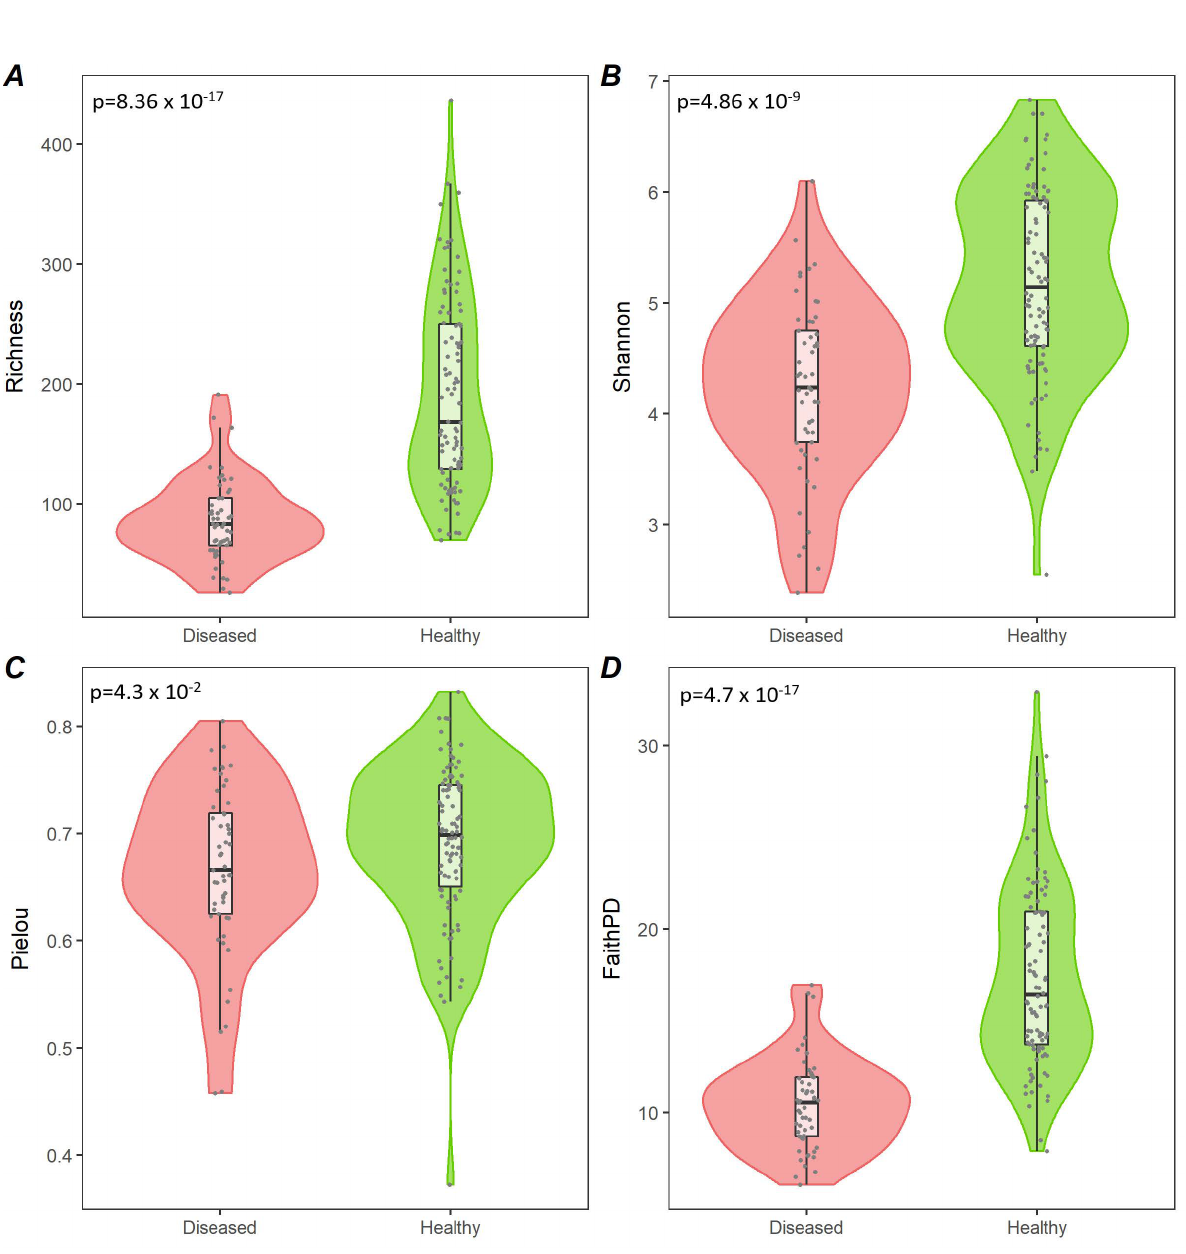
Figure 1. Alpha diversity comparison between healthy and diseased dogs. Violin plots representing alpha values in healthy (green) and diseased (red) groups according to richness ( A ), Shannon ( B ), Pielou ( C ), and Faith’s ( D ) phylogenetic diversity measures. The related p -values are visible in the top-left corner of each panel.